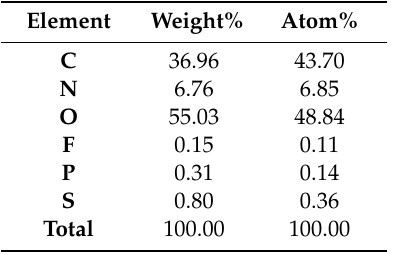
Figure 2. Scanning electron microscope image of the sieved biomass powder of Phragmites ; scale bar, 10 µm. Table 1. Energy-dispersive X-ray spectroscopy results of Phragmites biomass.